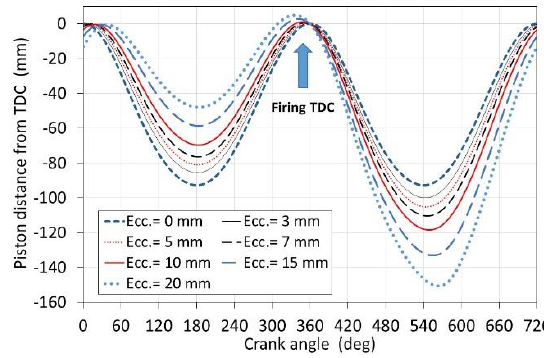
Fig. 9. Piston distance from TDC for various eccentricities